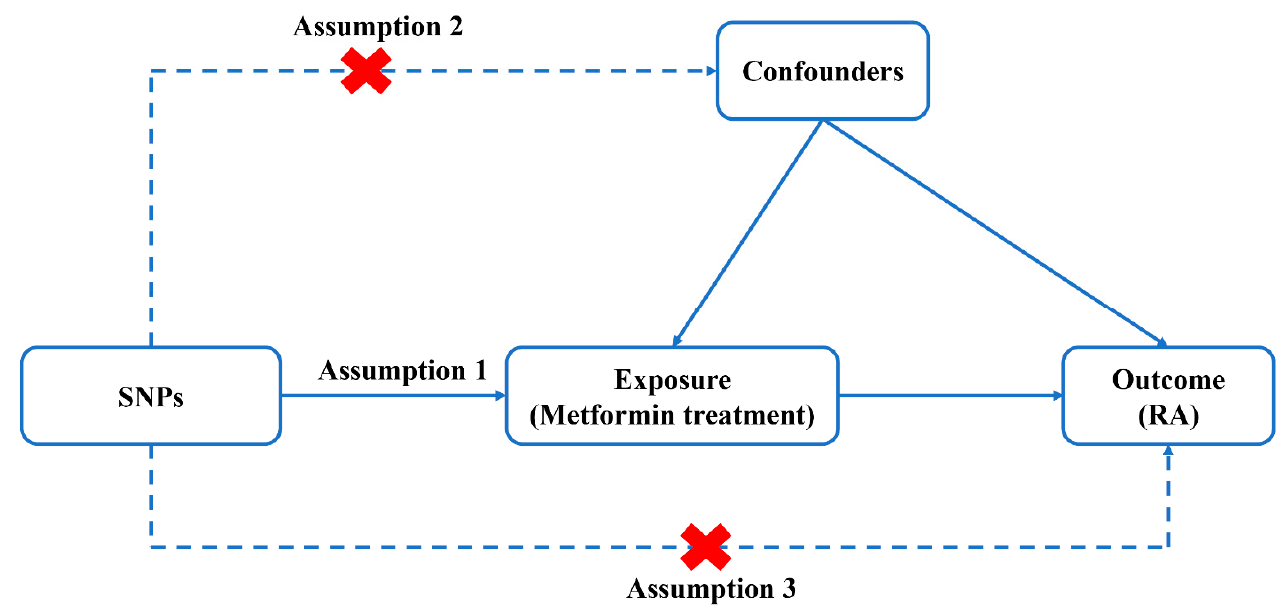
Figure 2. Diagram for Mendelian randomization (MR). MR is based on three hypotheses. First of all, SNPs identified as IVs should be strongly associated with exposure; secondly, selected SNPs must be independent of confounders; and finally, IVs are associated with RA (outcome) only via metformin use (exposure), rather than through a direct association.